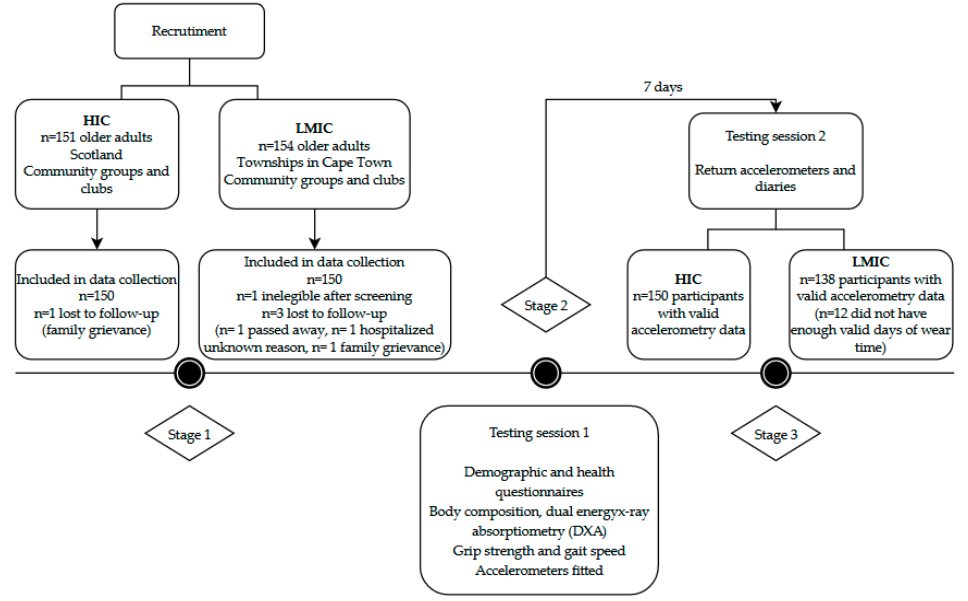
Figure 1. Recruitment and study design details.